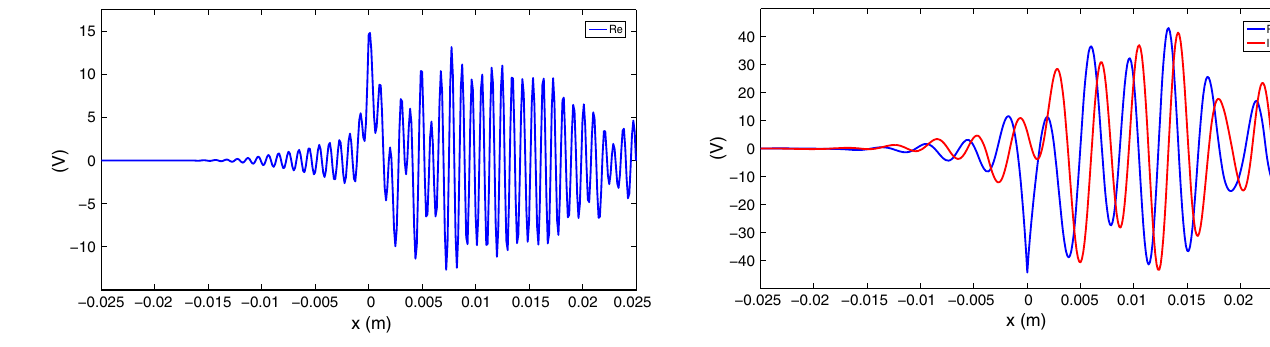
FIG. 10. The sum to p ¼ 9 of Z 0 end of the bend ( s ¼ 0 . 55 m) for kR ¼ 5 × 10 5 .